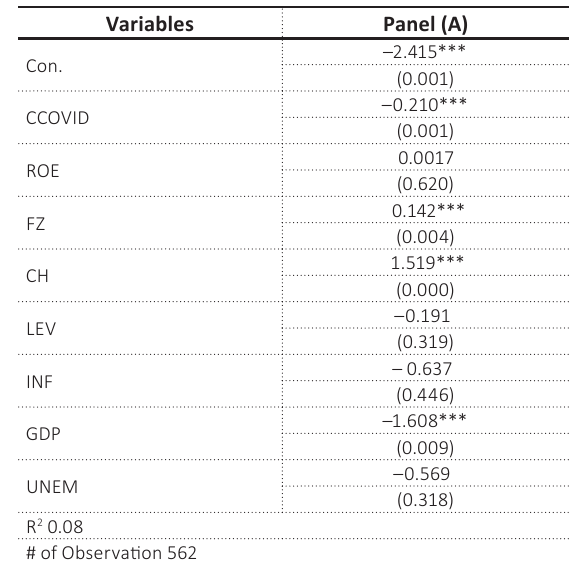
Table 7. Corporate immunity to the